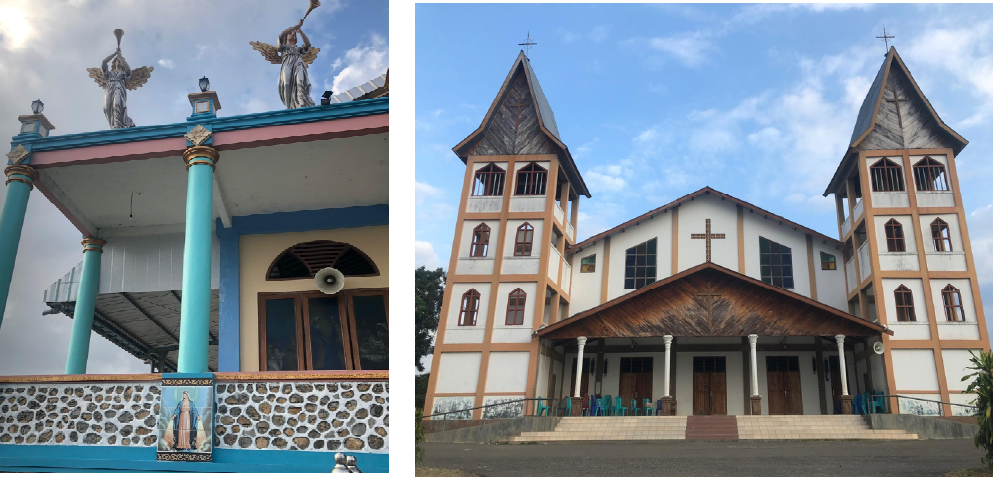
Figure 3. Loudspeakers that project the Angelus on the Paroki Maria Bunda Segala Bangsa Church ( left ) and the Gereja Katolik Paroki Roh Kudus ( right ) in Labuan Bajo, Flores. Photos by the author.